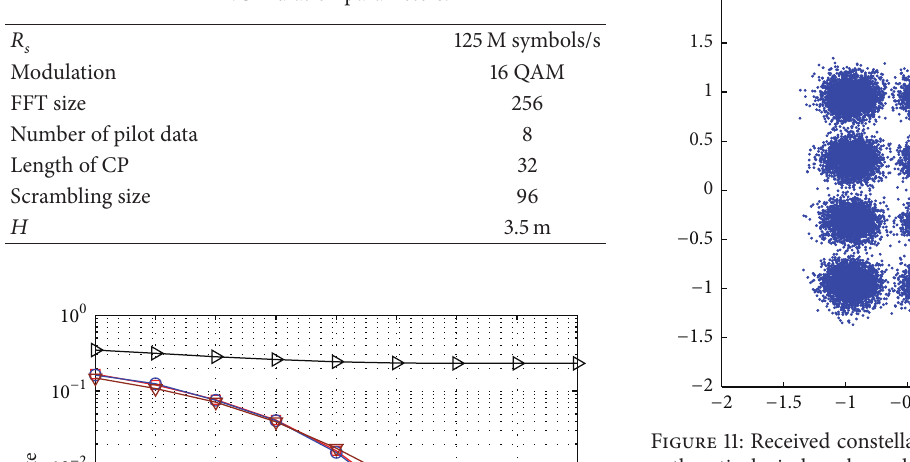
Table 1: Simulation parameters.